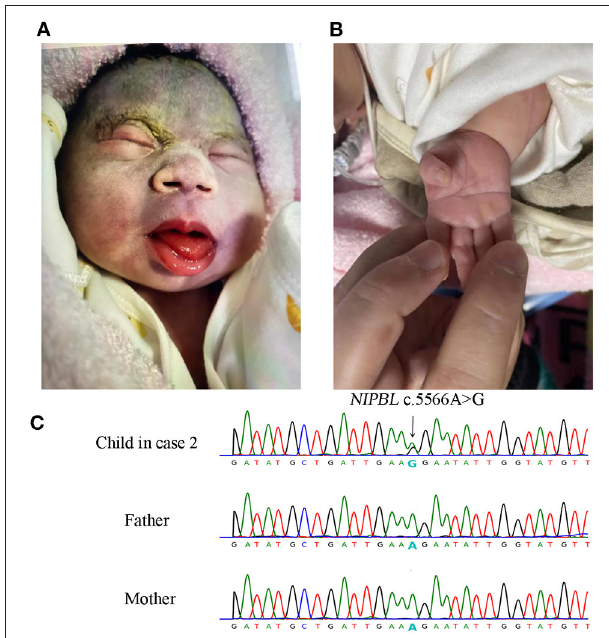
FIGURE 2 | Facial and limb features of the newborn and Sanger sequencing results of NIPBL c.5566A > G mutation in case 2. The newborn presented with low hairline, hypertrichosis of the eyebrows, broad depressed nasal bridge, smooth long philtrum with thin lips (A) , and single palmar crease (B) . Sanger sequencing validated the de novo c.5566A > G mutation in the newborn (C) .